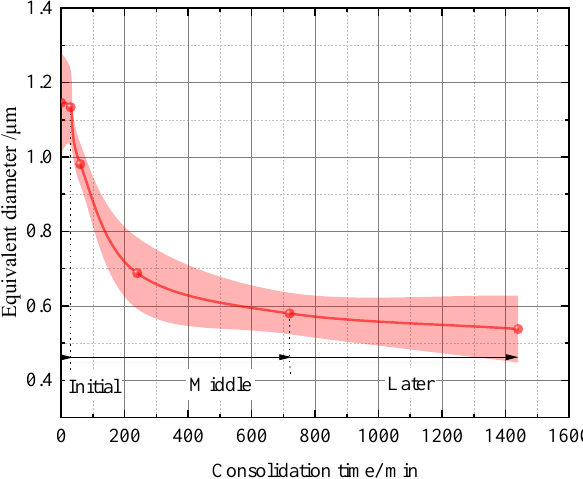
Figure 6. The curve of the average equivalent diameters of pores under different consolidation times.